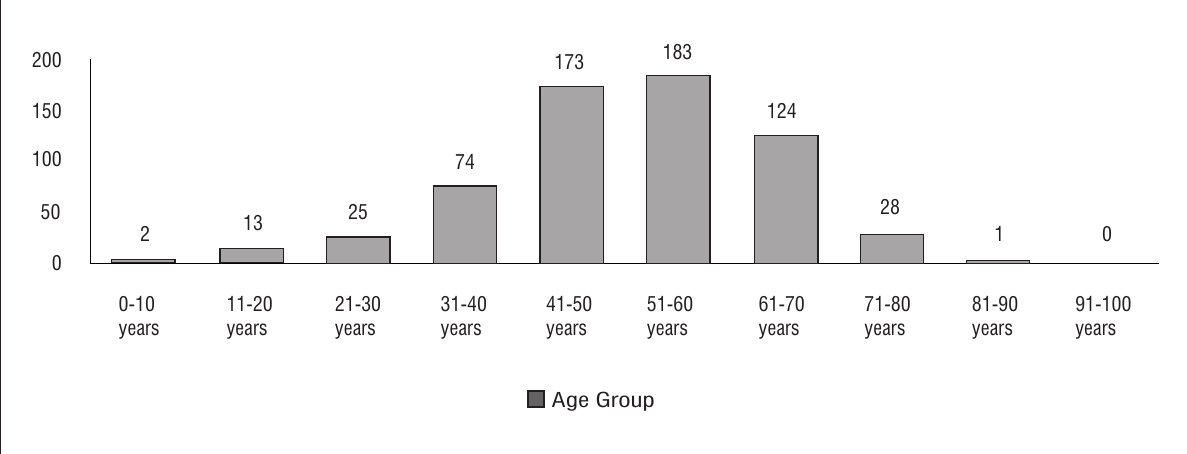
Figure 1 - Occurrence, by age group, of patients treated in the public physiotherapy sector in Boa Vista do Cadeado, RS